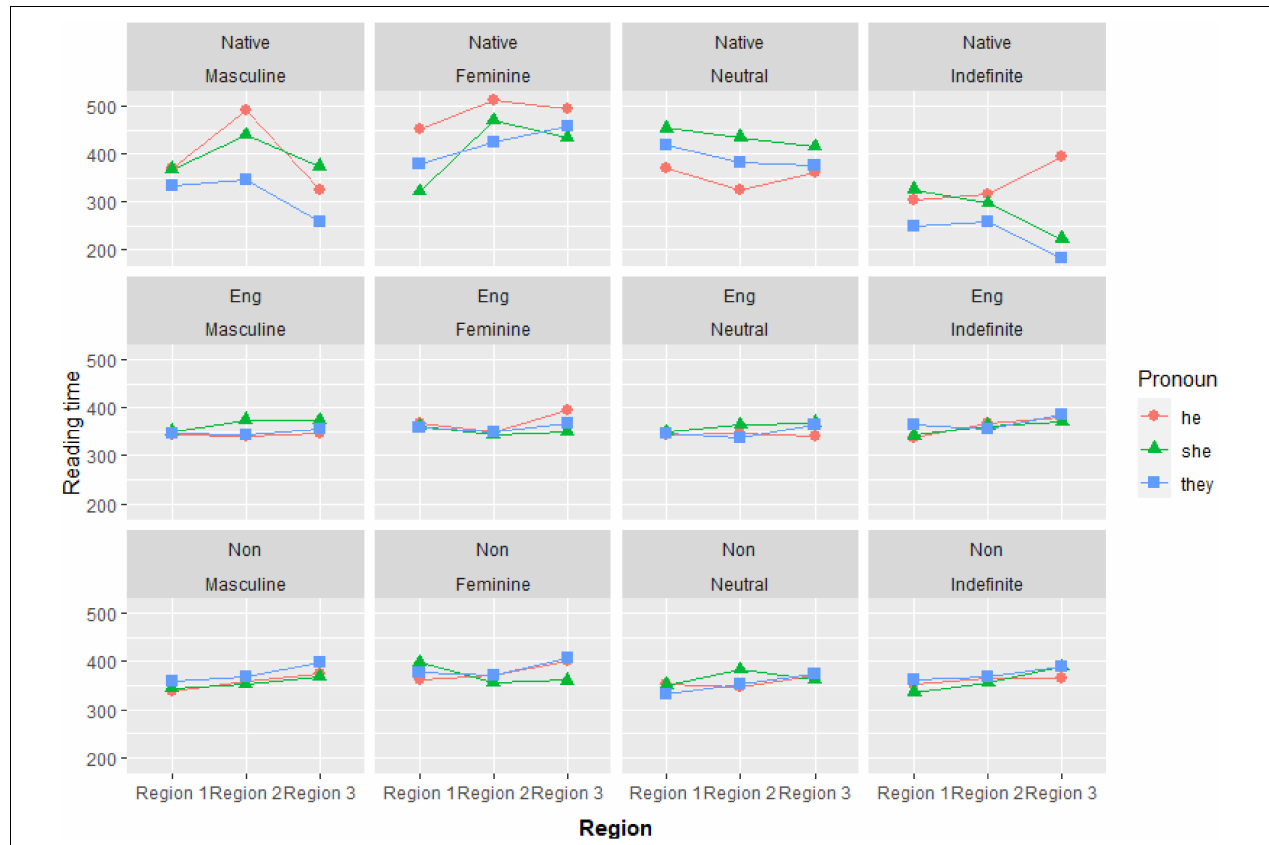
FIGURE 6 | The mean reading times of each pronoun by each group as a function of the antecedent type in different regions. ( Native , native English speakers; Eng , English majors; Non , non-English majors).